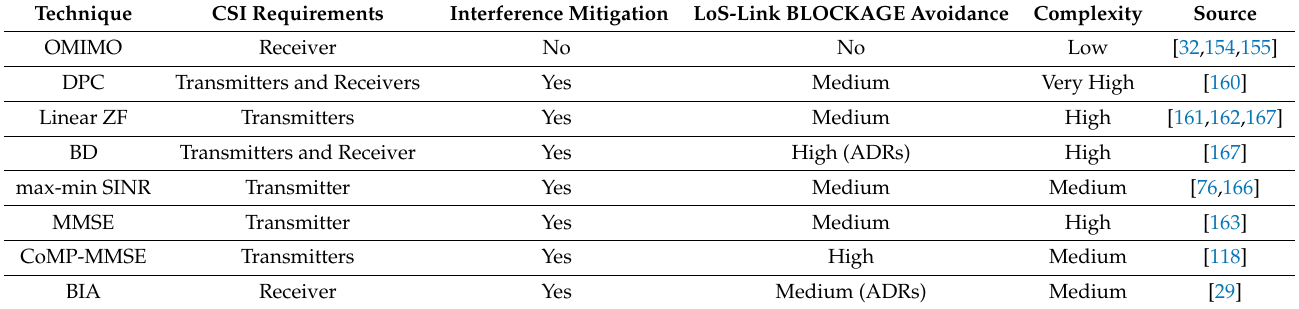
Table 4. VLC precoding